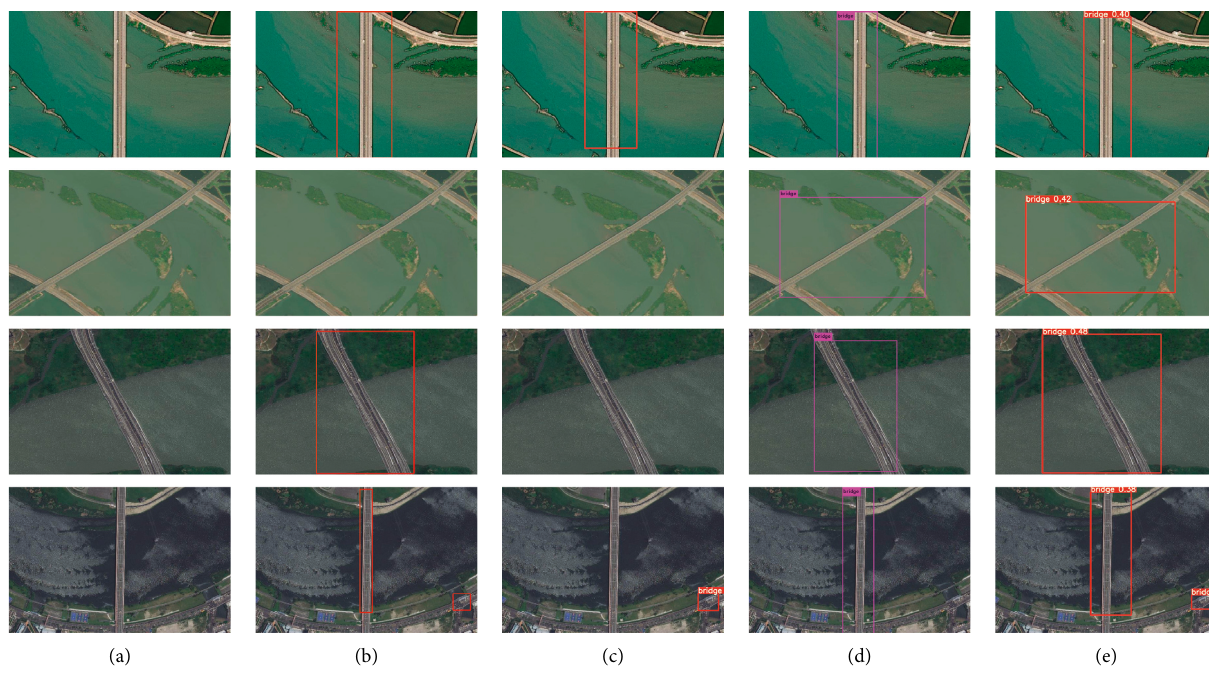
Figure 7: The comparisons of different competing methods for detection of large-scale bridges. From left to right: (a) original images and detected results by (b) Faster R-CNN, (c) YOLOv3, (d) YOLOv4, and (e) YOLOv5s, respectively.